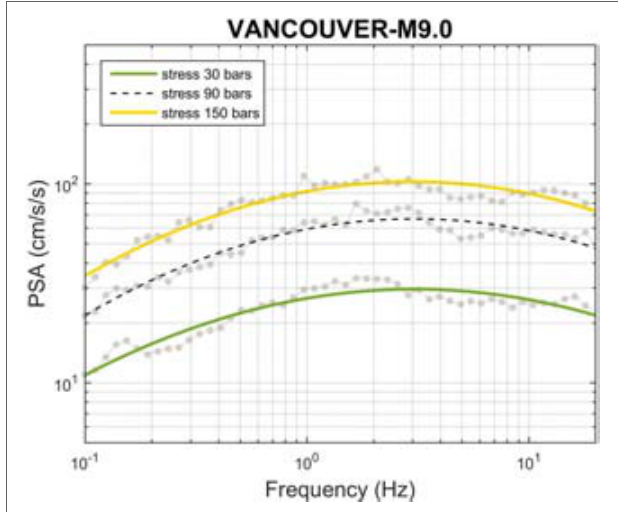
FIGURE 9 | Uncertainty in response spectra for M 9.0 at Vancouver due to stress parameter uncertainty. Light black dashed line is the average (over numerous simulations) PSA for Δσ = 90bar; green and orange solid lines are average PSA for Δσ = 30bar and Δσ = 150bar, respectively. Light gray dots are the average PSA values of 30 runs for the given stress parameters. The relative effect of stress parameter at Victoria is very